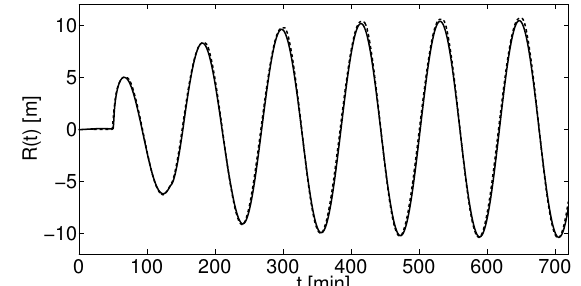
Figure 13. The run-up height of periodic waves with initial ampli- Fig. 13. The run-up height of periodic waves with initial amplitude tude A = 1m and frequency ω = 0 . 0009rads − 1 . The solid line is A = 1 m and frequency ω = 0 . 0009 rad/s. The solid line is the run- the run-up height calculated by employing the LSWE model in the up height calculated by employing the LSWE model in the simu- simulation area with the EBC implementation. The dashed one is lation area with EBC implementation. The dashed one is the result the result of coupling the NSWE model in the model area to the LSWE model in the simulation